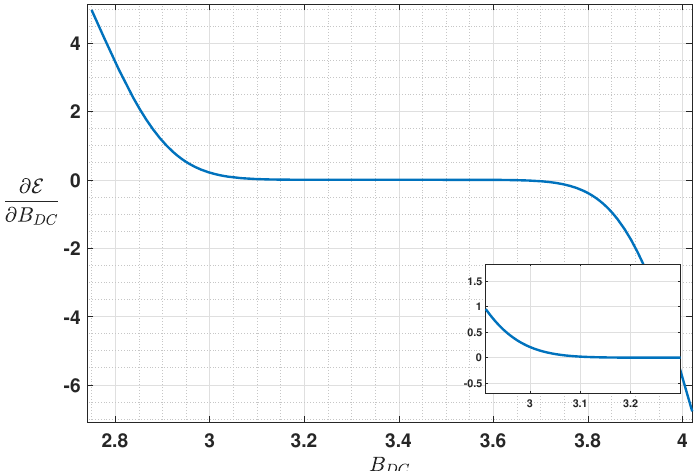
Figure A2. Partial derivation of E with respect to B 4-QAM modulation, P Tx,e = 50mW; N = 1024; N CP = 9; R b =